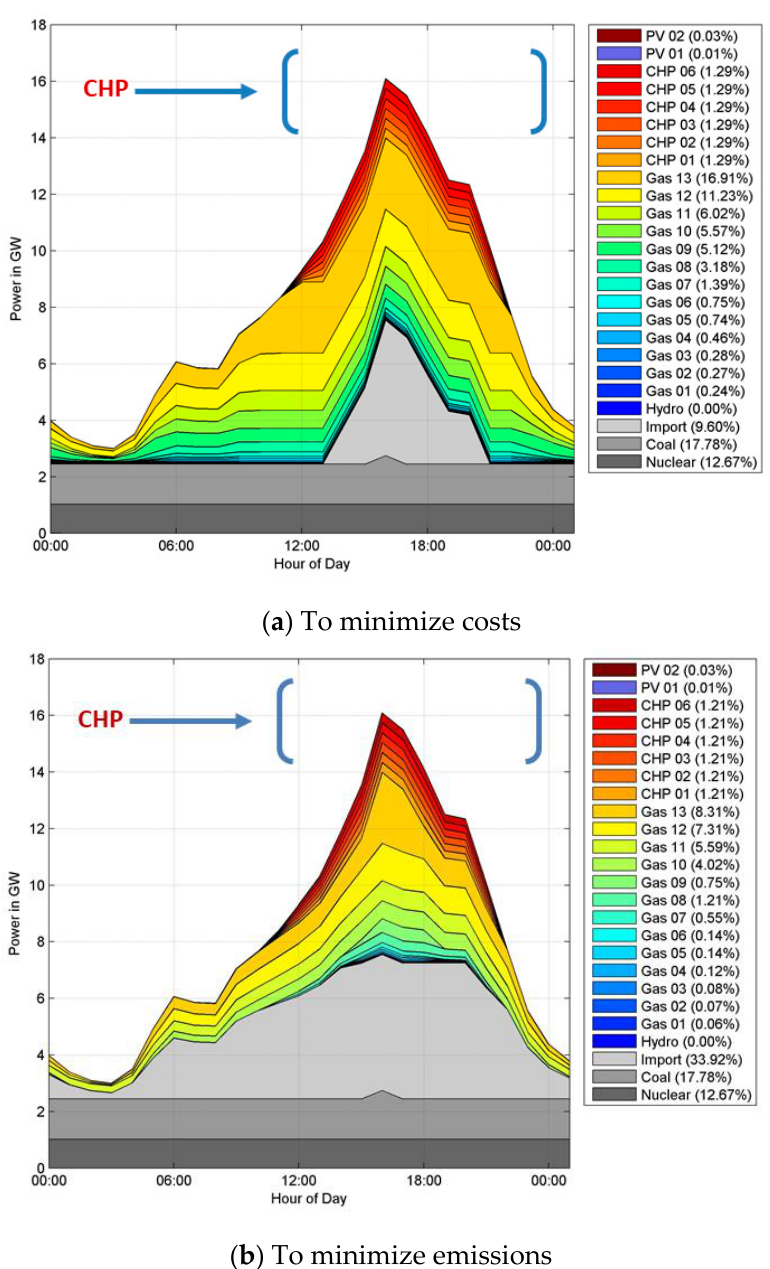
Figure 11. Daily profiles on a peak day in the Georgia, USA state grid.